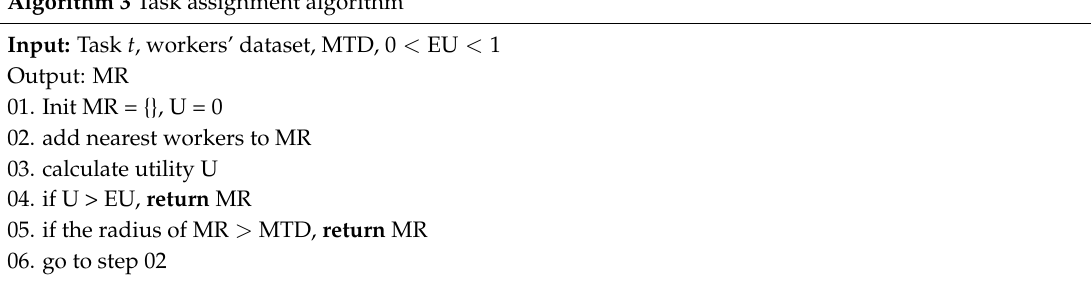
Algorithm 3 Task assignment